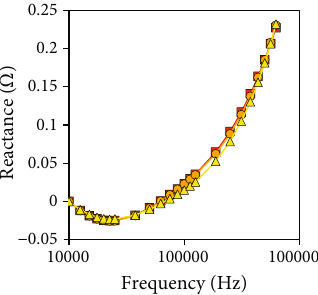
Figure 7: The di ff erence between resistance at each frequency and resistance at 10 kHz. The values of resistance were measured by ECM-1 with 0.5 molkg -1 (yellow open triangle), 1 molkg -1 (orange open circle), and 3 molkg -1 (red open square) KCl aqueous solution in the frequency range from 10 kHz to 625